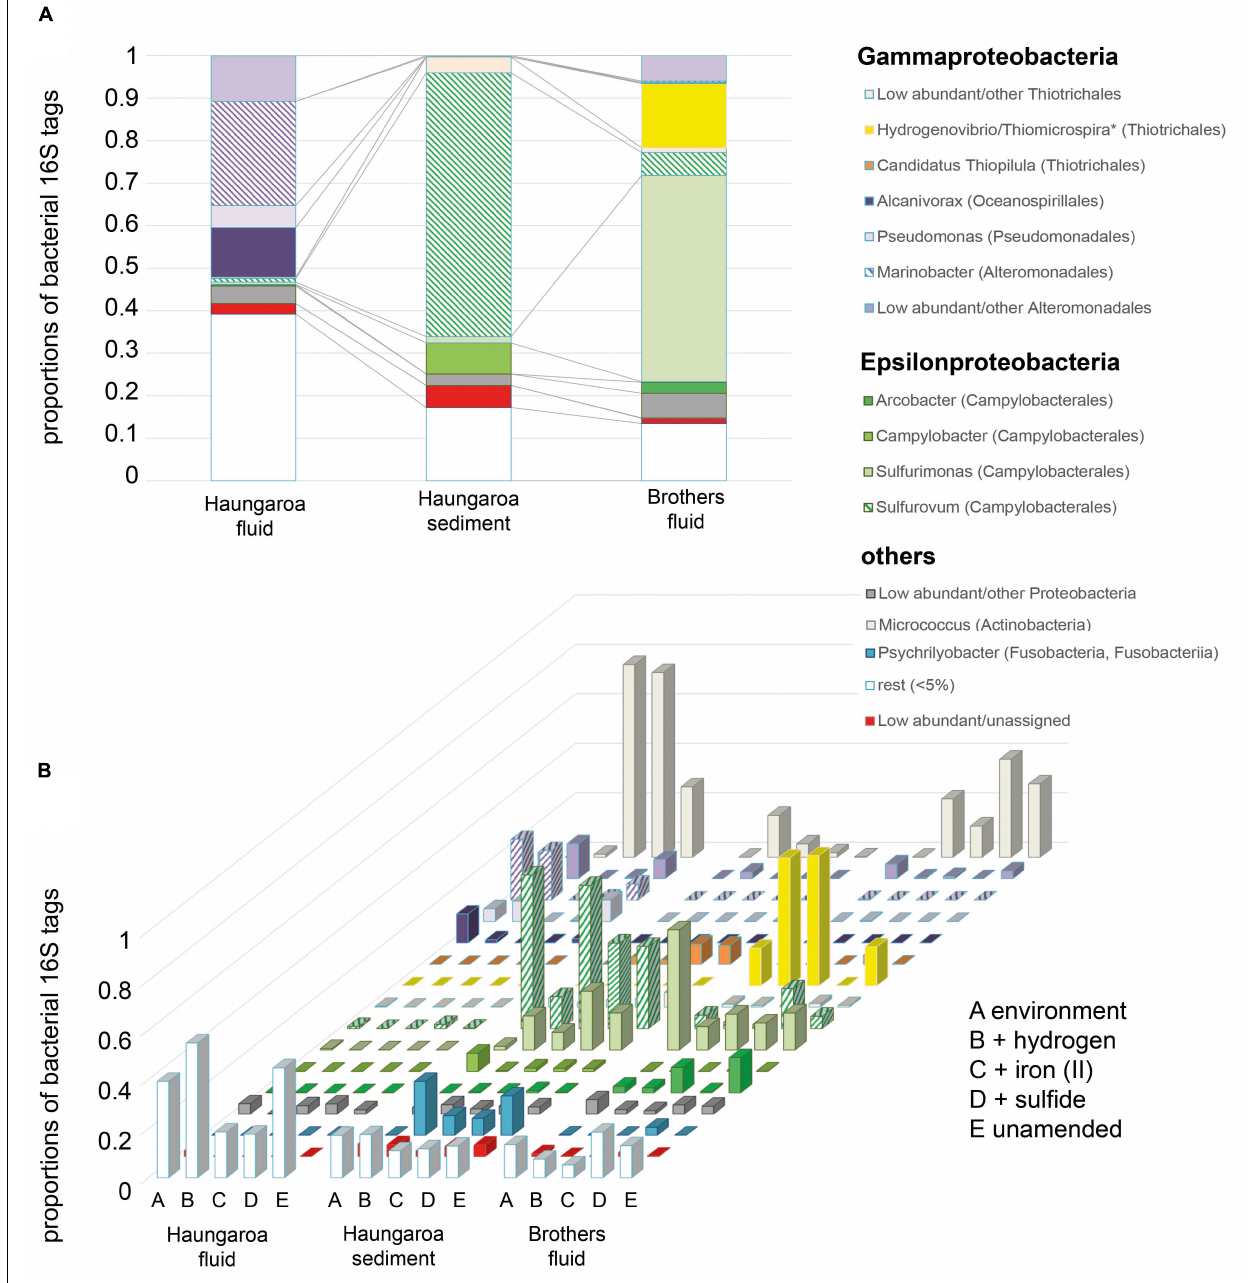
FIGURE 3 | Bacterial 16S rRNA tags with (A) DNA extracted from the environment, i.e., the Haungaroa fluids (30 ROV 4F) and sediment sample (35 ROV 15M) and from the Brothers fluid sample (61 ROV 13F-15F) and (B) RNA isolated from incubation experiments with sediment and fluid material. ∗ The genera Thiomicrospira and Hydrogenovibrio were recently evaluated and reclassified by Boden et al.